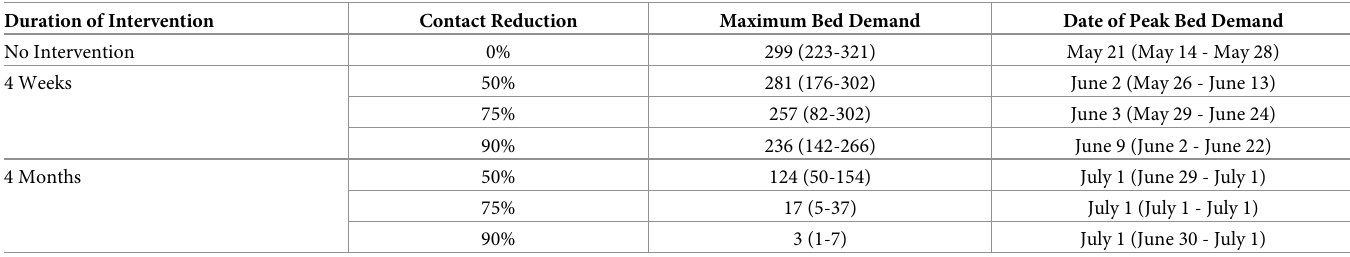
Table 3. Maximum isolation bed demand and date of peak with 95% confidence intervals over seven intervention scenarios. Duration of Intervention Contact Reduction Maximum Bed Demand Date of Peak Bed